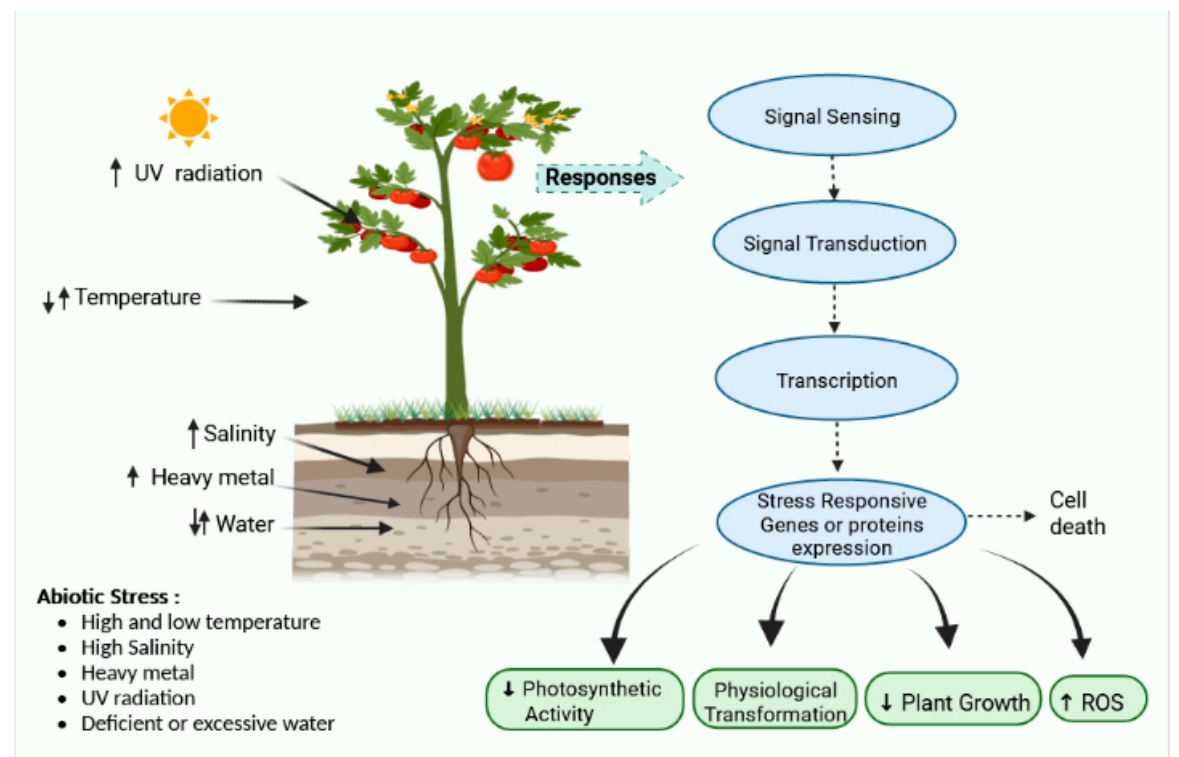
Figure 1. Effect of various stresses and their responses and pathways.